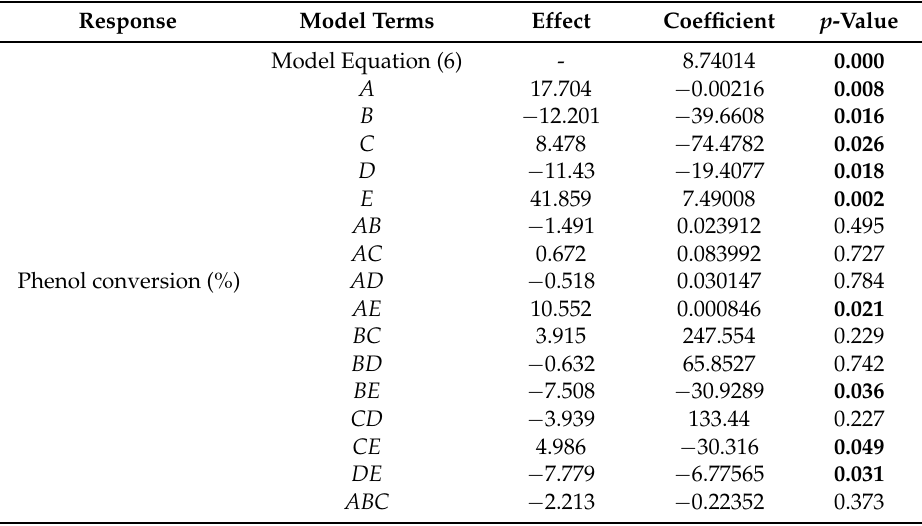
Figure 6. Parity charts of predicted versus observed responses for the initial models of ( a ) phenol conversion ( Y 1 ) and ( b ) hydrogen yield ( Y 2 ), including all main and interaction independent variables. Table 3. Analysis of the regression coefficient of the initial model for phenol conversion ( Y 1 ).